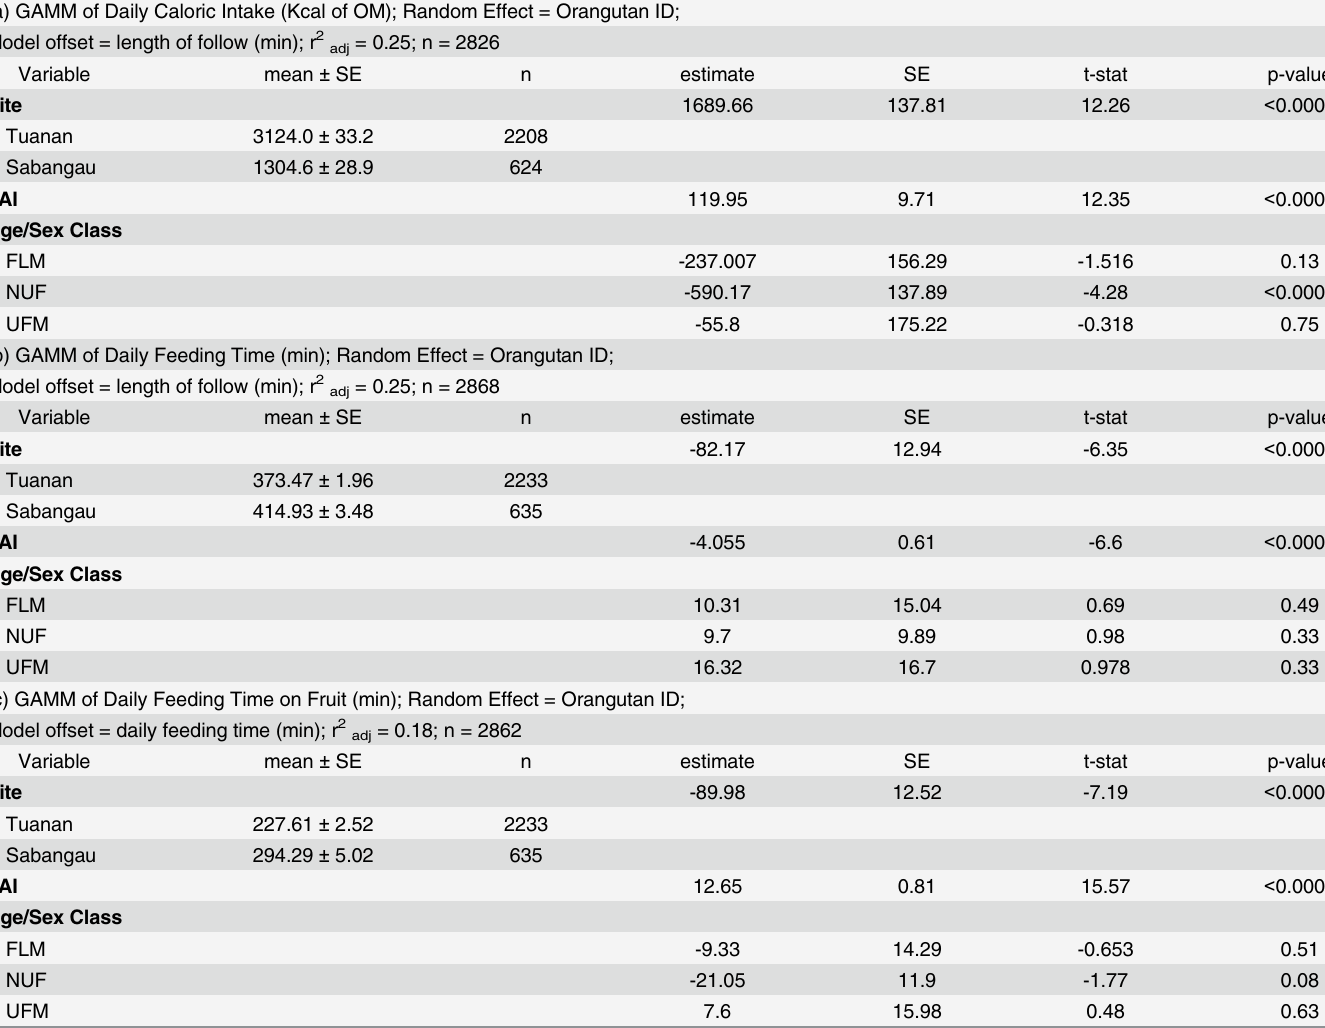
Table 3. Site variation in (a) Daily caloric intake, (b) Daily feeding time (min), and (c) Daily time spent feeding on fruit (min). All models include the variable age/sex class: FLM = flanged male; NUF = nulliparous independent female; UFM = unflanged adult male; AF = adult female; Age/Sex class compari- sons are against AF. FAI = Percentage of fruiting trees. (a) GAMM of Daily Caloric Intake (Kcal of OM); Random Effect = Orangutan